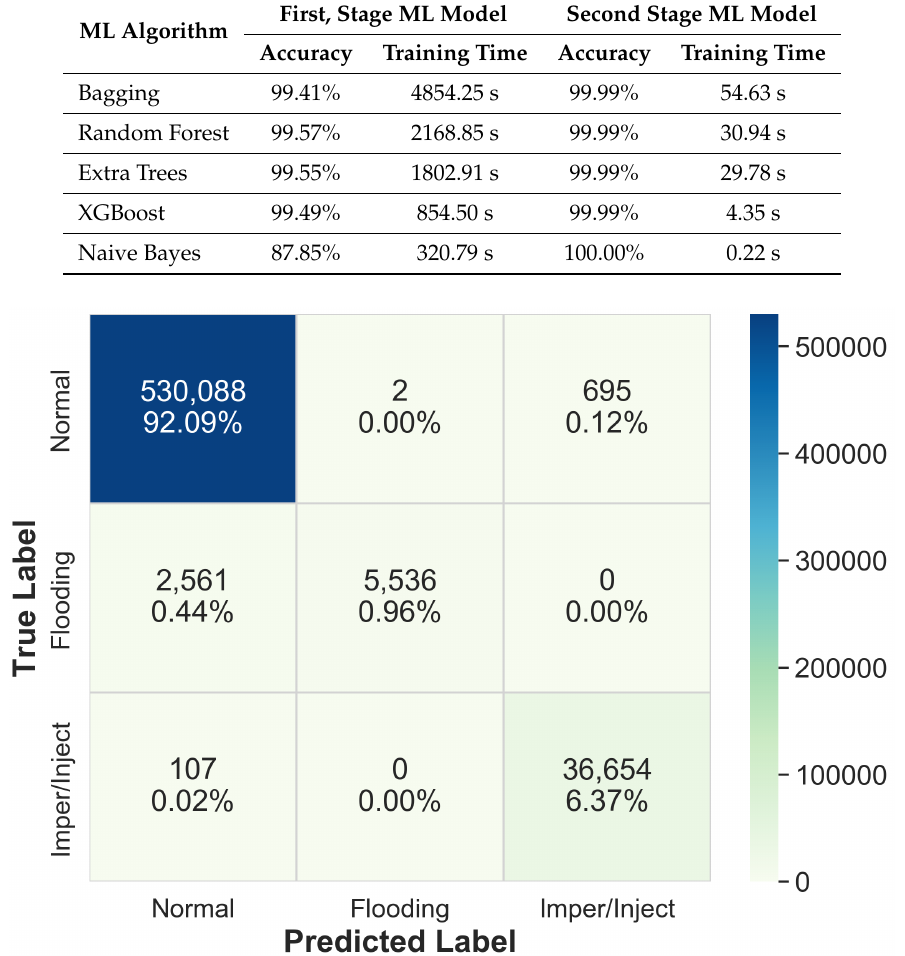
Figure 3. Confusion matrix of the first stage